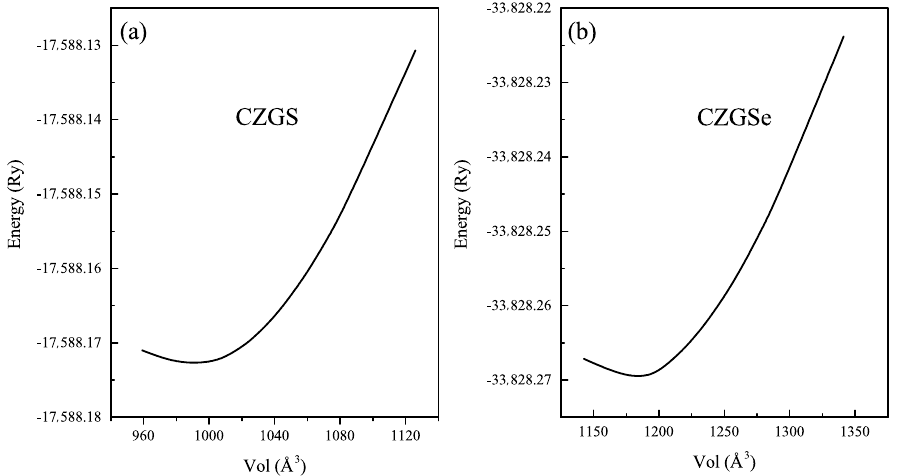
Figure 2. Total energy as a function of volume of ( a ) CZGS and ( b ) CZGSe in kesterite